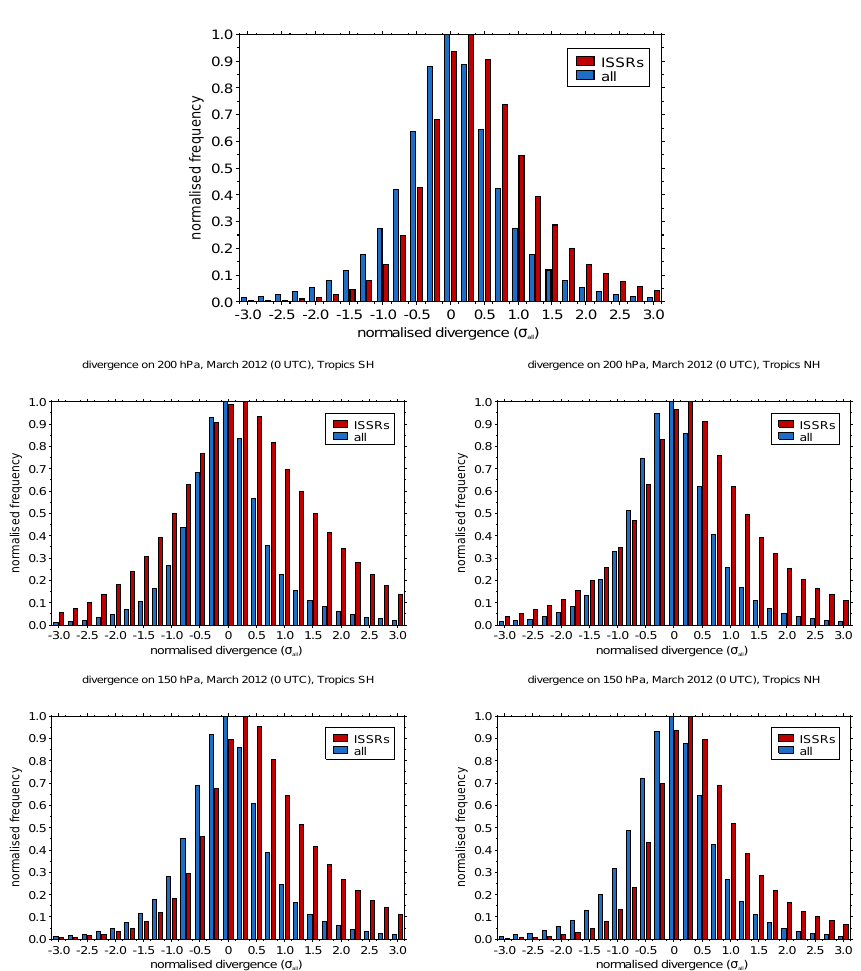
Fig. 1. Histograms of divergence for various regions: Europe on the 250hPa level (top row), and the tropics divided in Northern (NH, right) and Southern Hemisphere (SH, left) on 200 (middle row) and 150hPa levels (bottom row). The blue bars refer to all grid boxes in the respective region while the red ones refer to ISSRs only. The data are normalised with the standard deviation of the complete set of all forecast times and all grid boxes ( σ all ). The relative frequencies of occurrence are normalised such that the maximum value is unity. The bin width is σ all / 4 and the bins are marked with the small ticks on the x –axes.